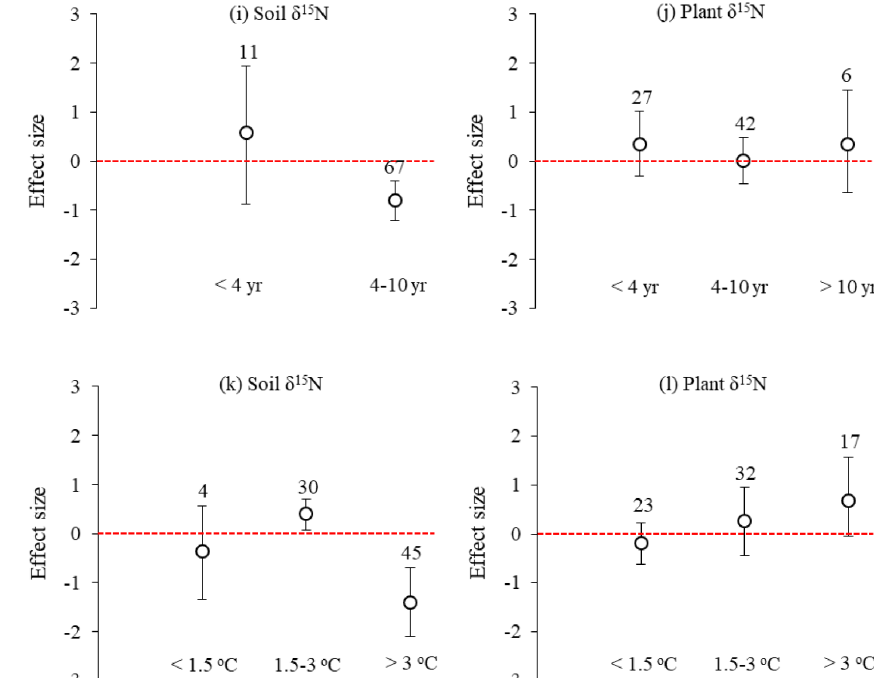
Figure 2. Factors influencing the effect sizes of the soil and plant δ 15 N under experimental warming from a global meta-analysis of 20 studies, including (a–b) soil acidity–alkalinity, (c–d) vegetation types, (e–f) warming treatments, (g–h) soil texture, (i–j) length of warming, and (k–l) increase in temperature. The error bars indicate effect sizes and 95% bootstrap confidence interval (CI). The warming effect was statistically significant if the 95% CI did not bracket zero. The sample size for each variable is shown next to the